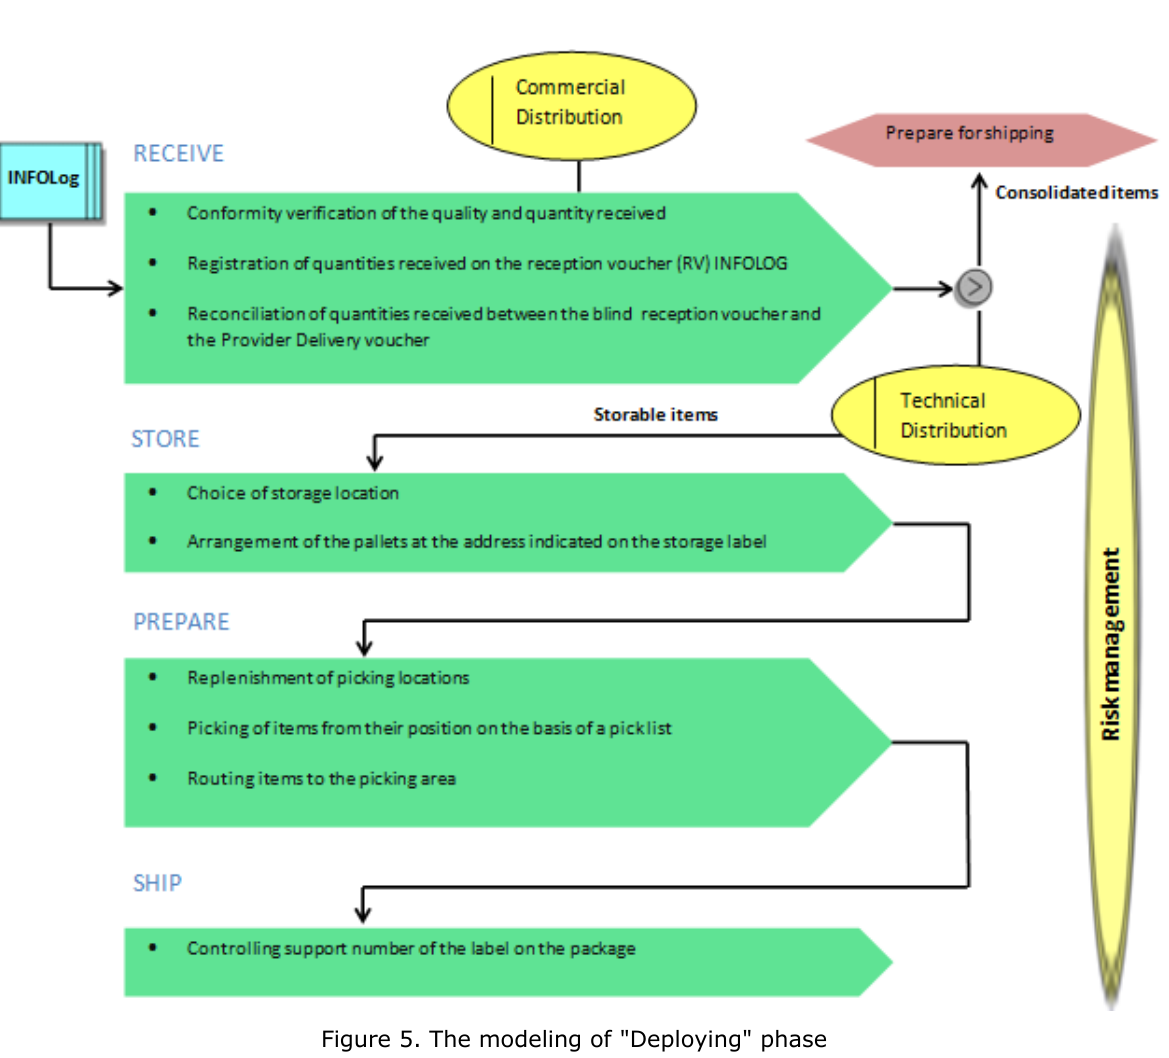
Figure 5. The modeling of "Deploying"